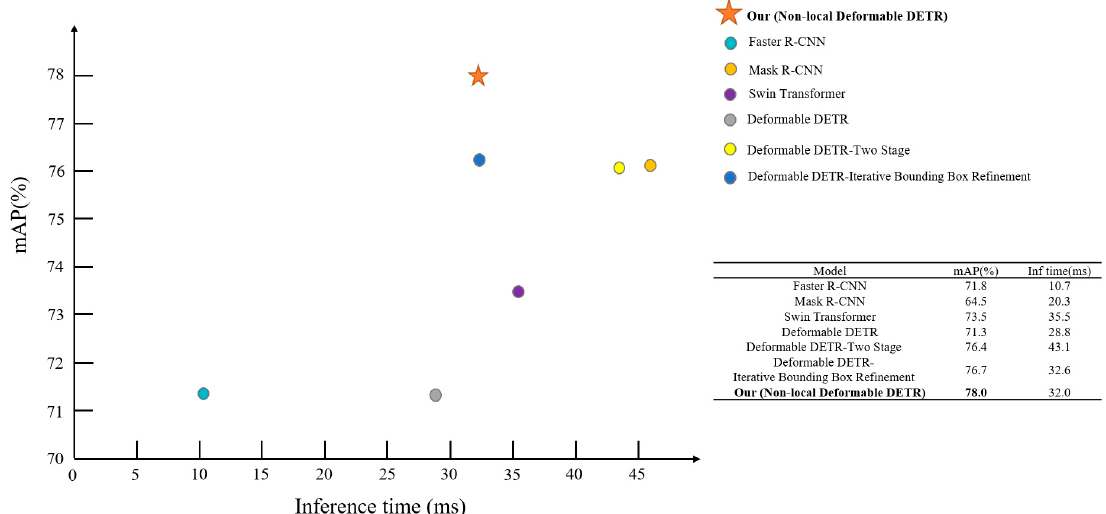
Figure 7. Performance comparison of different models.